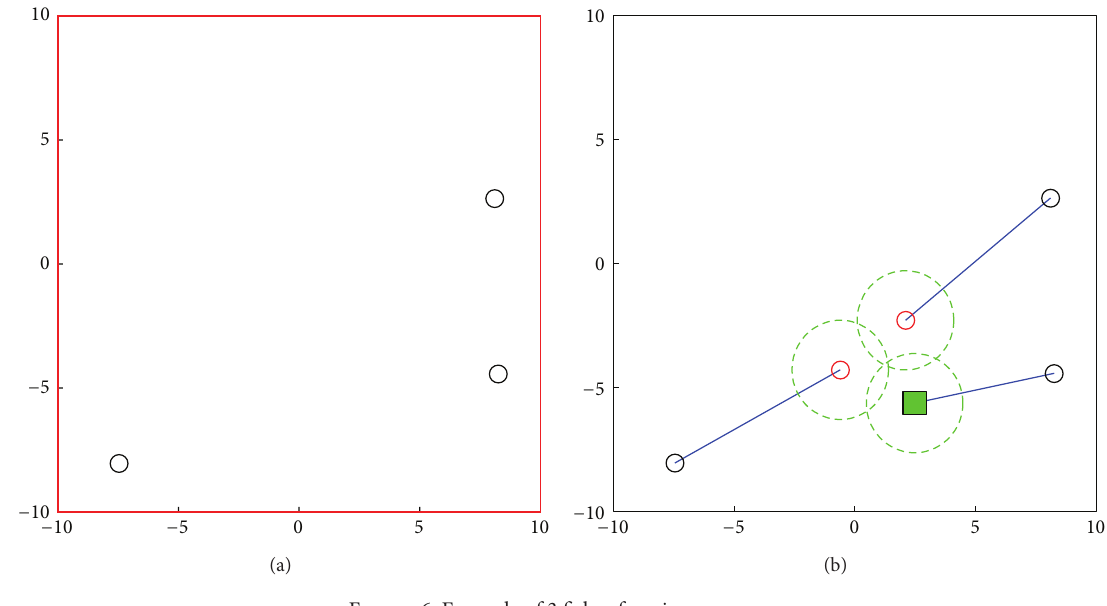
Figure 6: Example of 3 fishes forming a swarm.